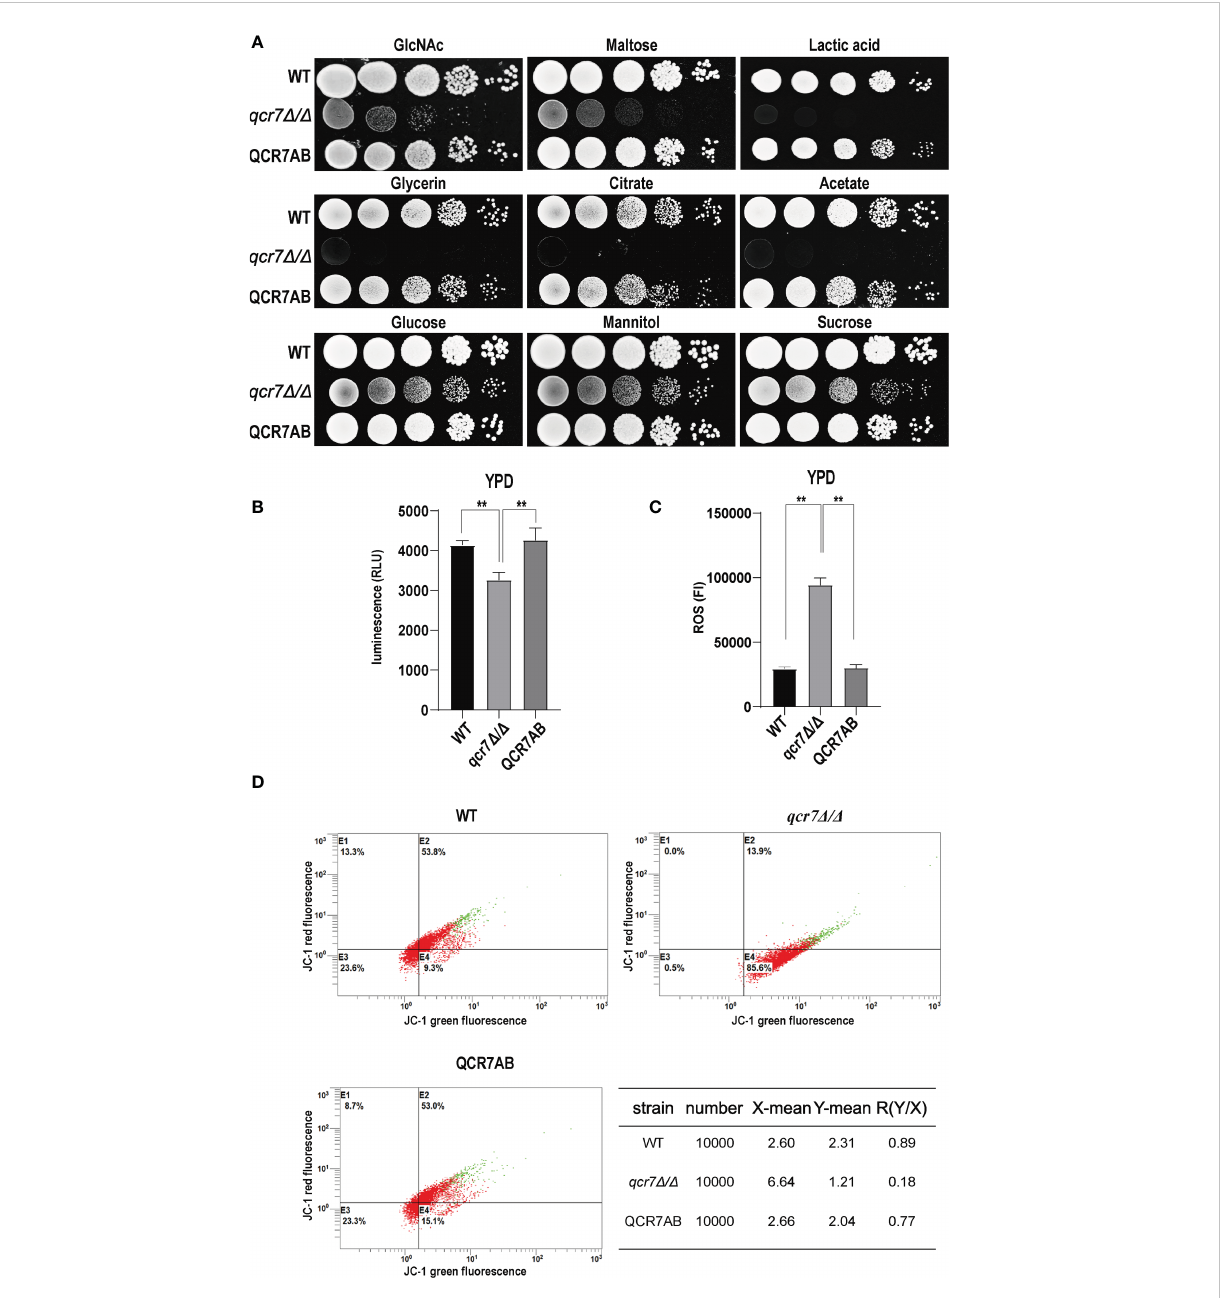
FIGURE 3 QCR7 is required for maintaining mitochondrial functions and carbon-source use. (A) Strains were cultured overnight in YPD, followed by washing and serial dilution with PBS. Different WT, qcr7 D / D , and QCR7AB concentrations (5 m l of 10 7 cells/ml to 10 3 cells/ml) were spotted on solid YEP media containing 2% glucose and several alternative carbon sources. Plates were then photographed after incubation at 30°C for 2 days. (B) The intracellular ATP content was measured using a microplate reader. “ ** ” represents p < 0.01 for the WT vs. mutant strains. (C) ROS levels